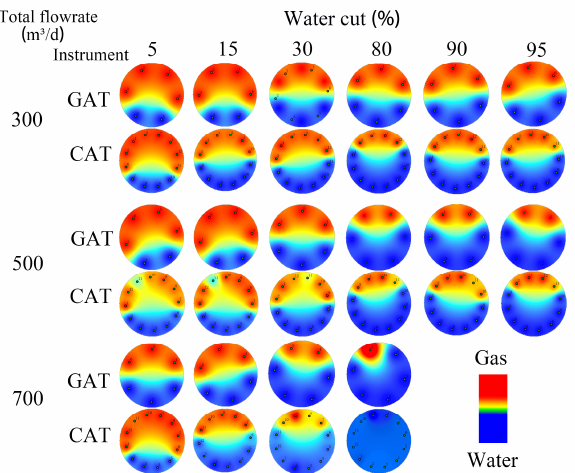
Figure 6. Comparison of GAT and CAT interpolation imaging under different measurement con-